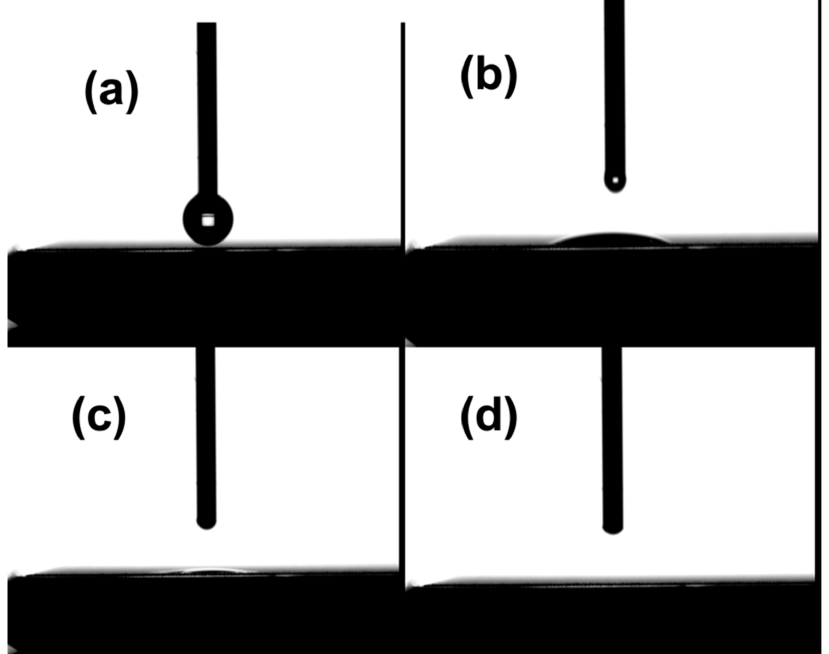
Figure 7. ( a – d ) Water contact angle test of the laser-treated surfaces showing superhydrophilic properties. From ( a – d ), the images show the frame by frame formation of a drop contacting the surface and dispersing on the laser-treated surface within a fraction of a second. The Tafel extrapolation method was used to determine the corrosion potential (E corr ) and corrosion current ( I corr ) from the cathodic polarization curves. Figure 8a shows the polarization curves for the laser-structured and annealed samples. The results show that the annealing process produced a stable oxide layer, which caused passivation in the la- ser-structured samples with a positive shift in E corr for 6 W (0.5 V), 9 W (0.49 V), 12 W (0.34 V), and 15 W (0.28 V), respectively. However, there were very small changes in the I corr . This was due to the passive oxide layer that acted as a physical barrier to corrosion or further oxidation, thus decreasing the current density [82–84]. Furthermore, Figure 8b shows the laser-structured samples treated at laser powers of 6, 9, 12, and 15 Watts. Those samples demonstrated poor anticorrosive performance, associated with current densities of 22.2, 31.6, 7.53, and 3.79 µA/cm 2 , compared to the pristine sample (1.93 µA/cm 2 ). These high I corr values of the laser-structured samples could be attributed to the increase in the effective surface area, which increased the electrode to electrolyte interface, thus increas- ing the sites of attack for the reactive ions present in the solution and leading to decreases in the corrosion resistance of the surface [84–86].